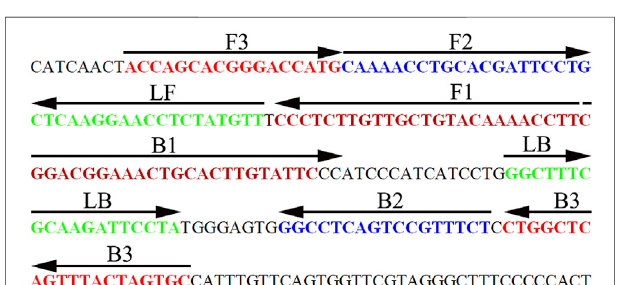
FIGURE 3 | Sequence and location of the HBV-speci fi c S gene used to design HBV-LAMP-LFB primers. The nucleotide sequence of the sense strand of the HBV S gene is shown in the diagram. Right arrows and left arrows indicate sense and complementary sequences, respectively.